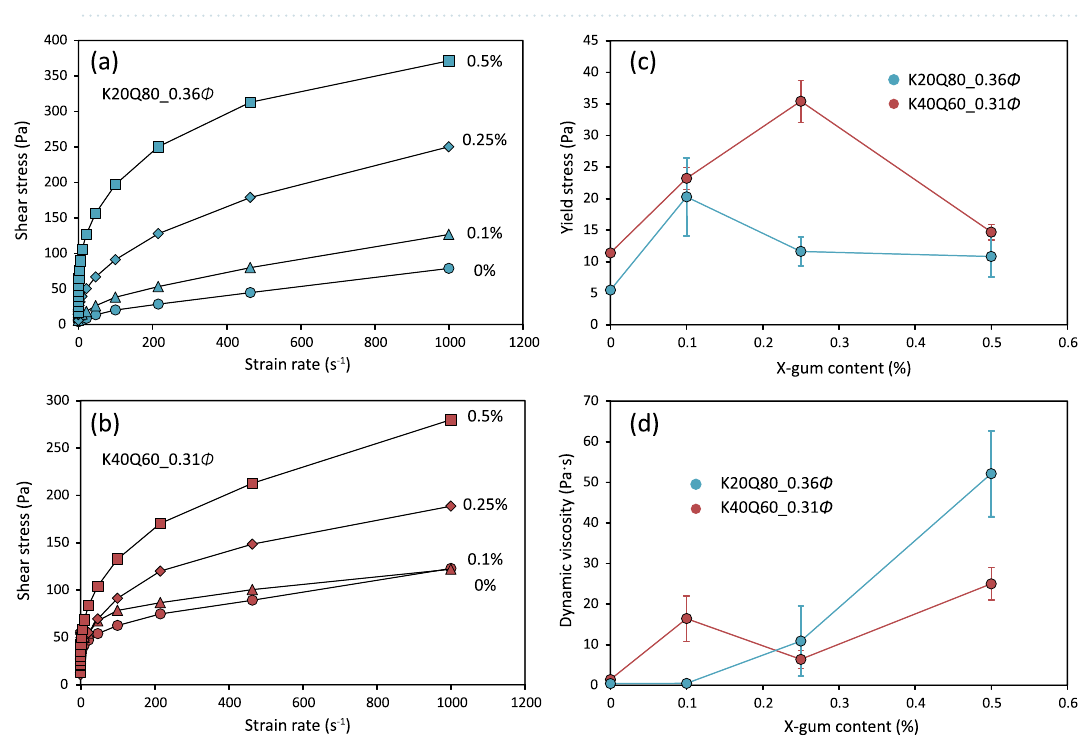
Figure 3. Flow curves for suspensions ( a ) K20Q80_0.36 Φ and ( b ) K40Q60_0.31 Φ with different xanthan gum contents, and plots of ( c ) yield stress and ( d ) dynamic viscosity versus xanthan gum content. Error bars denote the maximum and minimum values in three repeated